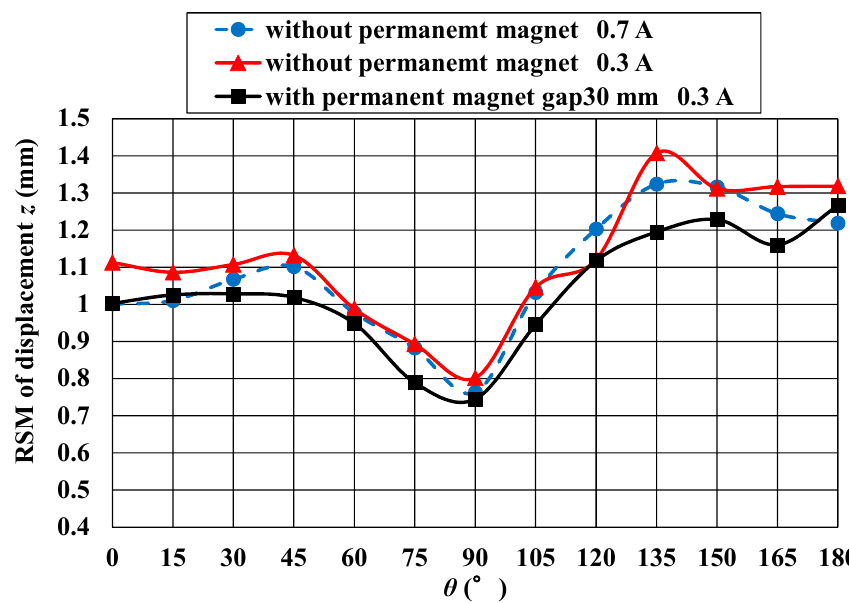
Figure 11. Experimental results of each guideway.